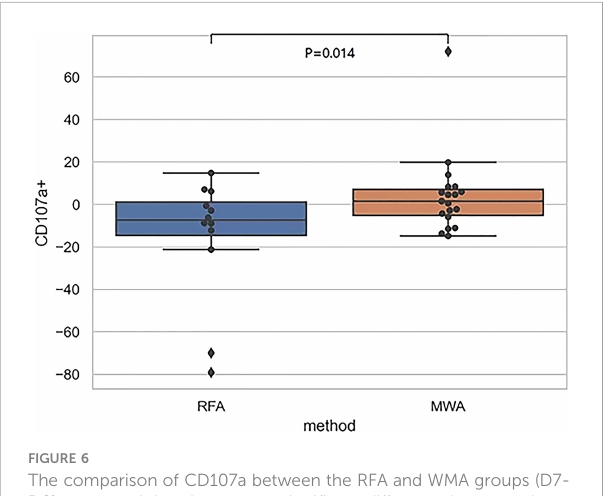
FIGURE 7 Comparison of the NK cell lysis activity of the target K562 cells between the RFA and WMA groups showed that there was no difference in D0, D7,